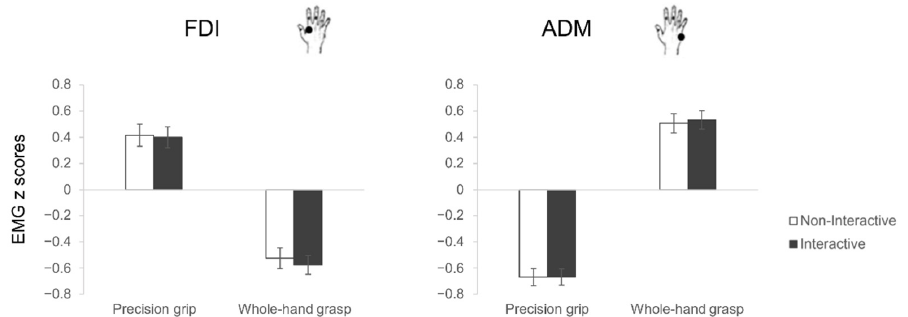
Figure 4. EMG results. The bar charts show EMG activations (z scores) during action execution of precision grips (PG, stirring) and whole ‐ hand grasps (WHG, lifting) under Non ‐ Interactive (white) and Interactive (black) conditions. The error bars represent standard error of the mean.